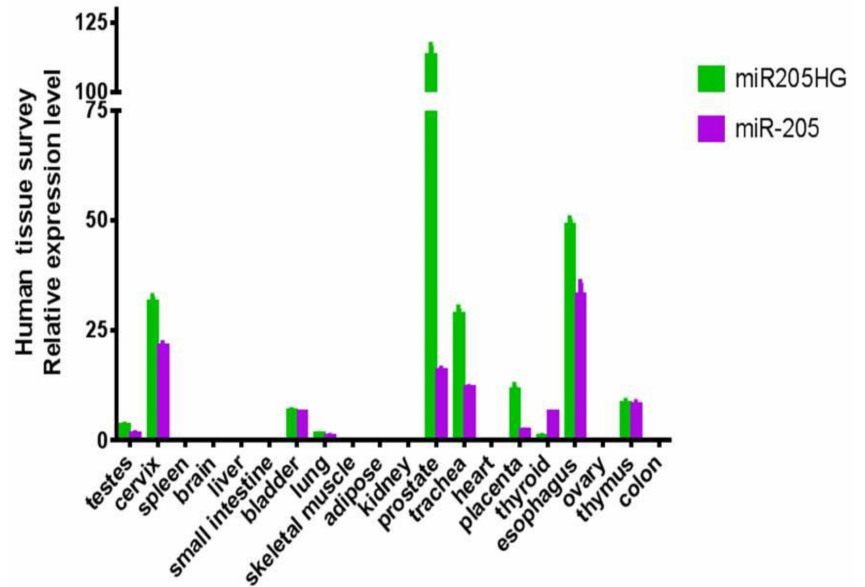
Figure 6. miR205HG expression in various normal human tissues. Twenty different normal human tissues were assessed for miR205HG expression by qRT-PCR. miR205HG was expressed in normal esophagus, cervix, prostate, trachea, and